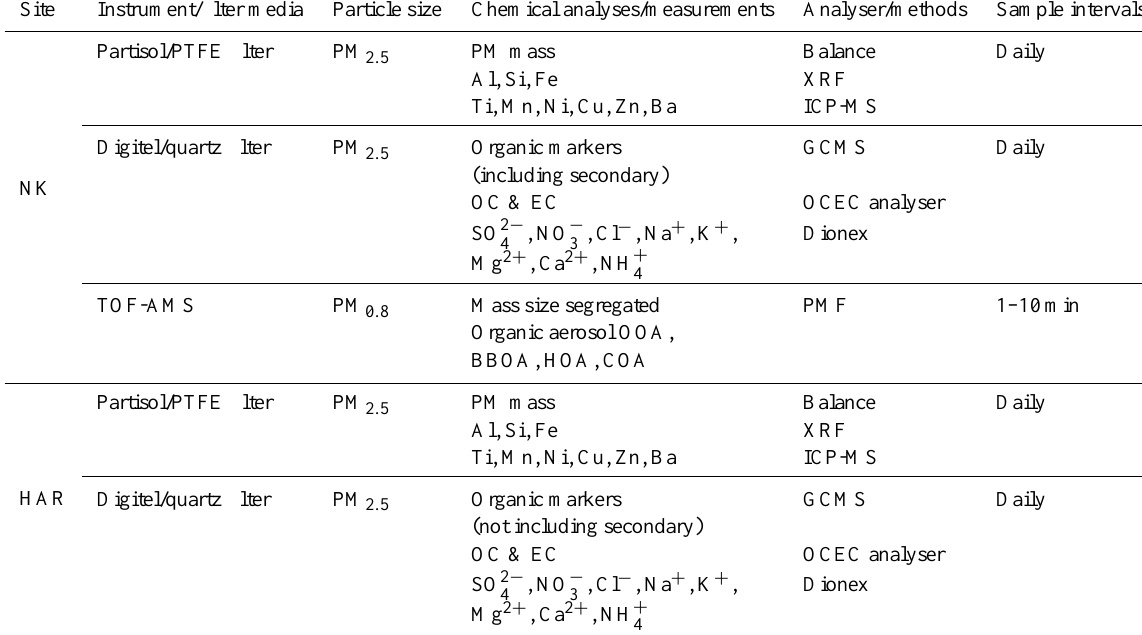
Table 1. Air sampling and analytical